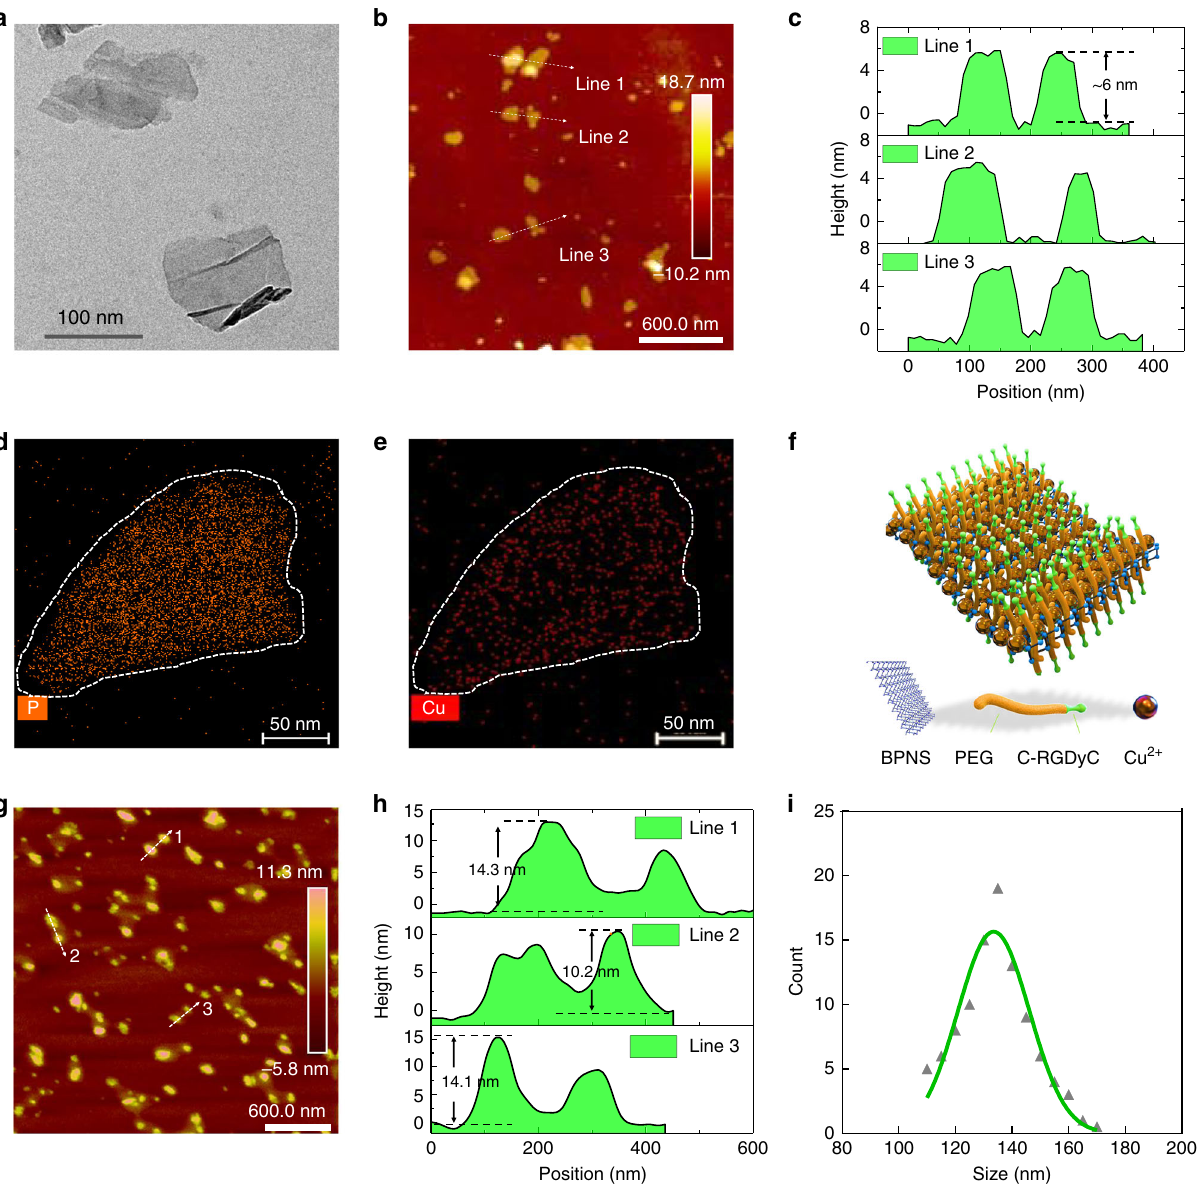
Fig. 2 Characterization of BPNS-based nanomaterials. a TEM image of BPNS. Similar TEM images of BPNS were obtained for more than three times experiments. b AFM image of BPNS. c Height pro fi les of BPNS along the white lines in ( b ). d , e STEM elemental mapping of P and Cu for BP@Cu hybrid nanosheets, respectively. Similar STEM mapping images were observed for more than three independent experiments. f Schematic diagram of the composition and structure of BP@Cu@PEG-RGD. g AFM image of BP@Cu@PEG-RGD. h Height pro fi les of BP@Cu@PEG-RGD along the white lines in ( g ). i DLS measurements of the hydrodynamic diameter of BP@Cu@PEG-RGD (0.1 mg/mL of BPNS) in PBS. Abbreviations: AFM atomic force microscopy, TEM transmission electron microscopy, STEM scanning TEM, DLS dynamic light scattering, PBS phosphate-buffered